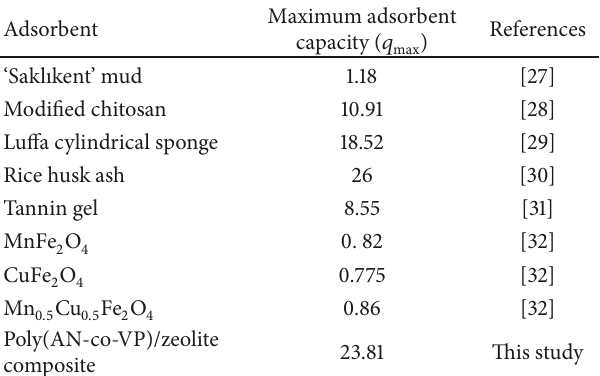
Table 3: Comparison of maximum adsorbent capacity of BG with different